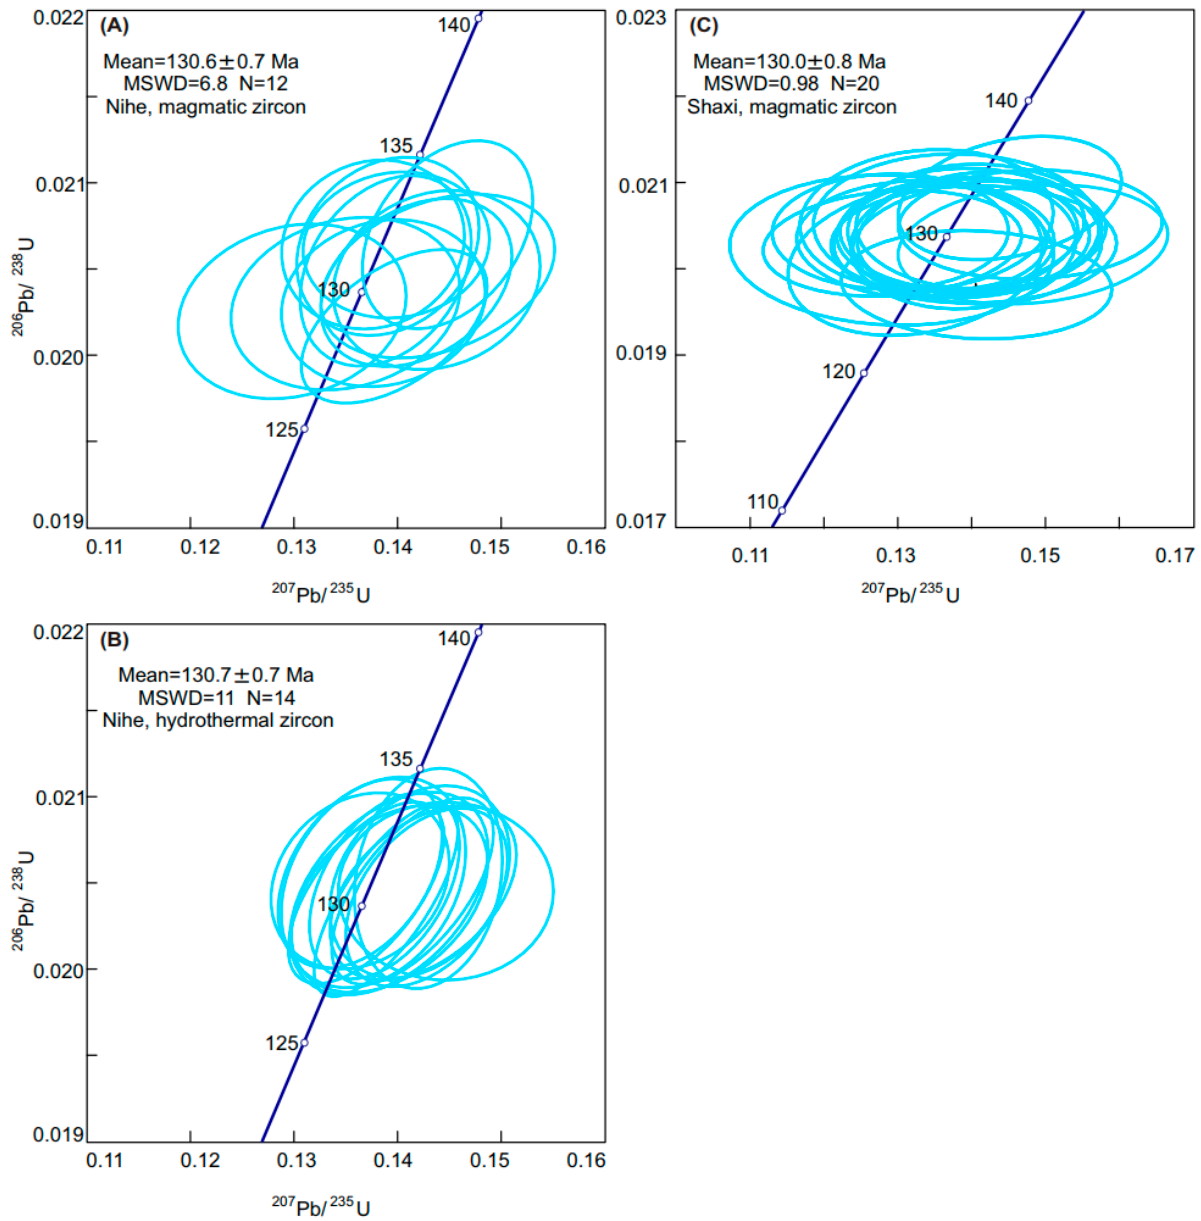
Figure 7. Concordia diagrams of LA-ICPMS magmatic zircon U–Pb for Nihe ( A ) and Shaxi ( C ), and hydrothermal zircon U–Pb for Nihe ( B ).